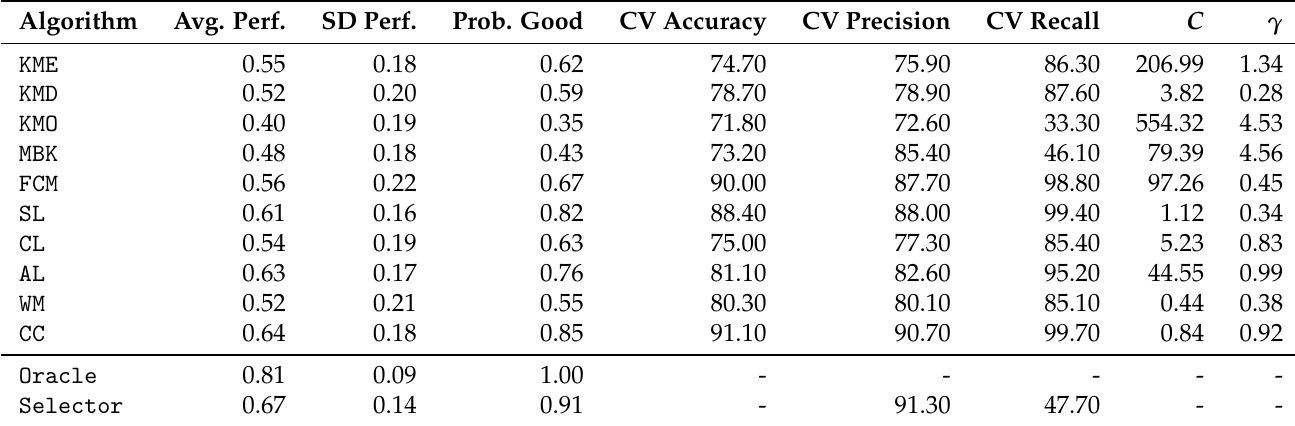
Table 4. Results of SVM prediction models, where Avg. Perf. is the Average Performance, SD Perf. is the Standard Deviation Performance, CV Accuracy, CV Precision and CV Recall are cross-validated performance metrics, C is the cost in the regularization term and γ is the RBF